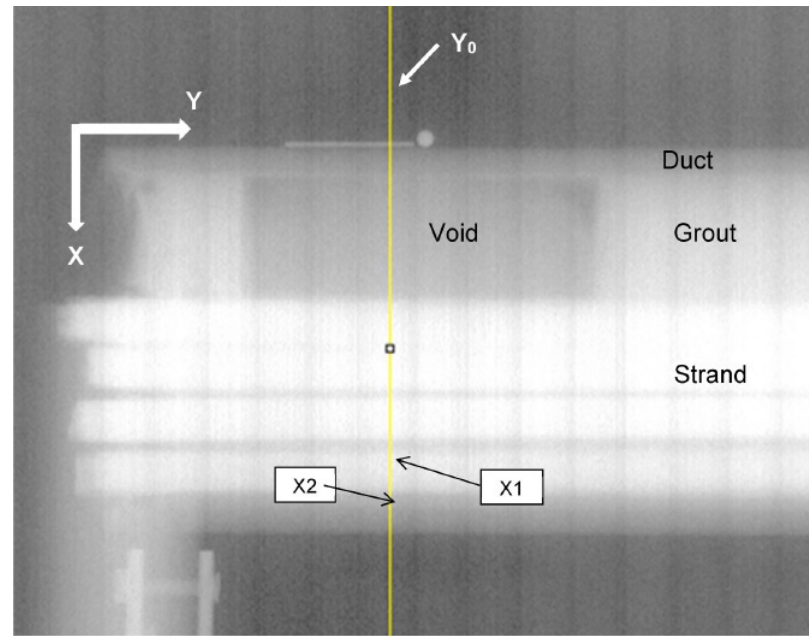
Figure 9. Photo captured by gamma-ray with interpretation [9].